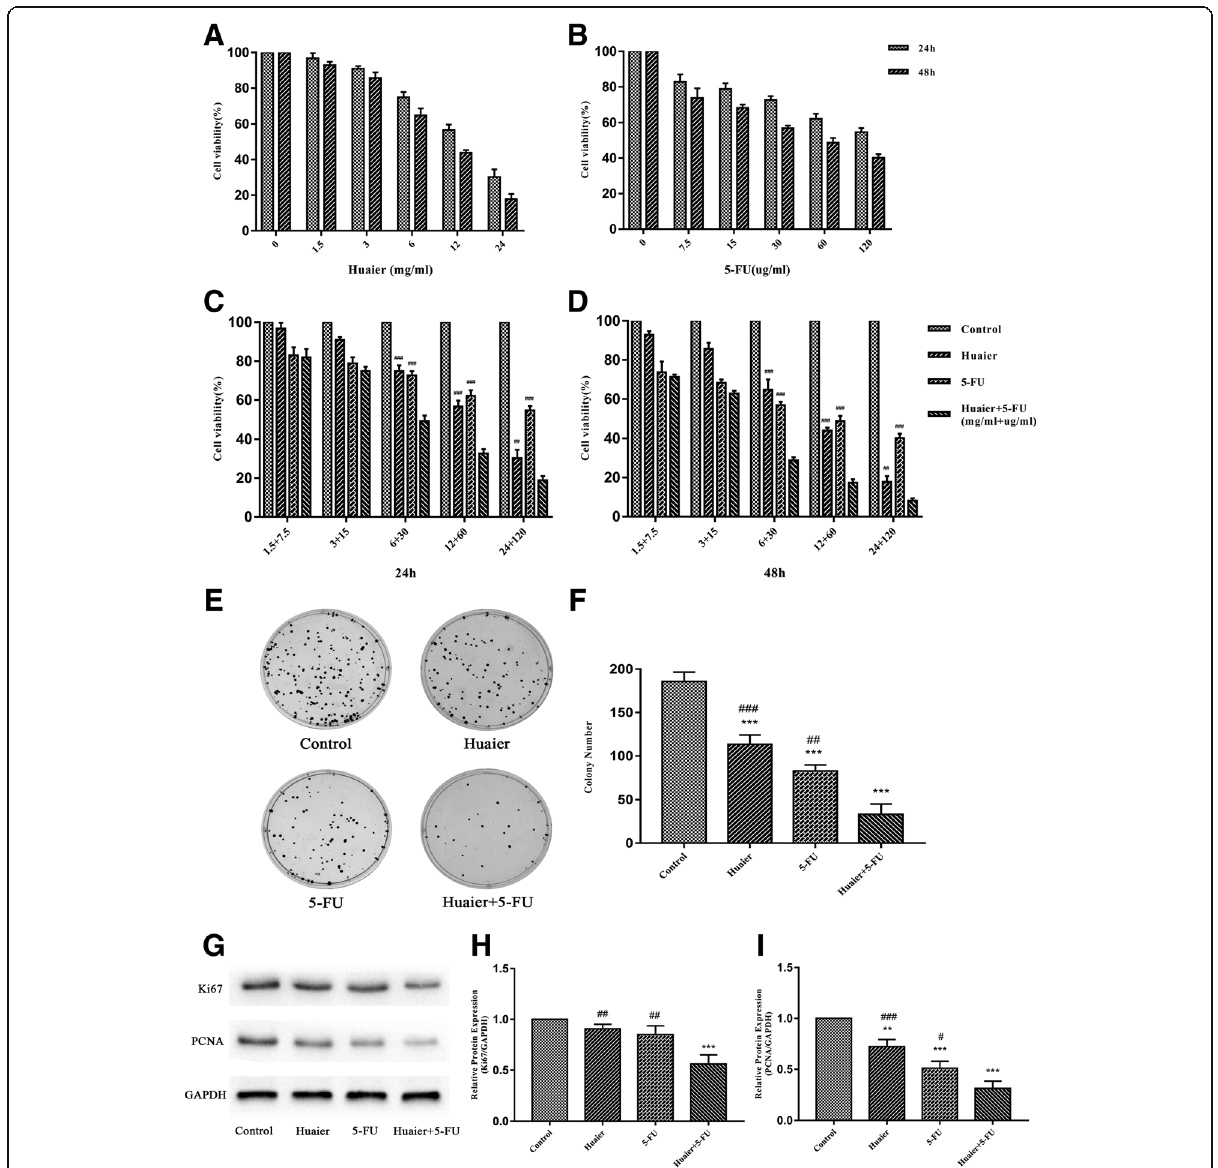
Fig. 1 The effect of Huaier and 5-FU treated alone or in Combination on cell proliferation and colony formation in Huh28 cells. a and b After being treated with Huaier (1.5-24mg/ml) or 5-FU alone (7.5-120 μ g/ml) in different concentrations for 24 h and 48 h, the cell viability was measured with CCK-8 assay. c and d Cell proliferation ability was also assessed after cells were treated with Huaier and 5-FU alone or in combination for 24 h and 48 h. e and f The inhibiting effects on colony formation by treated monotherapy or in combination were shown, and the colony numbers were calculated. g and h The protein expressions of Ki67 and PCNA in Huh28 cells after 48 h treatment with Huaier and 5- FU alone or in combination were measured with western blot, and relative optical density of the proteins expression was analyzed using Image J. All data are expressed as the mean ± S.D. of three separate experiments. * P < 0.05, ** P < 0.01, *** P < 0.001, compared with control group, while # P < 0.05, ## P < 0.01, ### P < 0.001, compared with combination group. i The panel labels “ 24h ” and “ 48 ” represent the samples were detected after treatment 24 hours and 48 hours respectively. The panel labels “ Control ” , “ Huaier ” , “ 5-FU ” and “ Huaier+5-FU ” represent the samples were treated by neither of two drugs, Huaier extract, 5-Fluorouracil and combination of two drugs